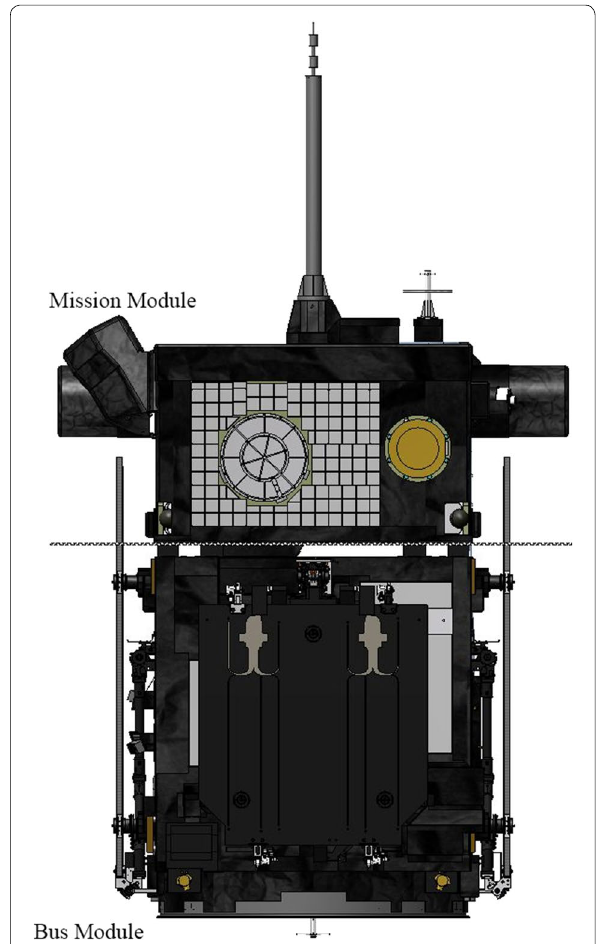
Fig. 1 Cross-view of the Arase spacecraft. The lower part of the broken line slightly above the middle is the bus module and the upper is the mission module. Observation equipment is attached to the mission module section and acquires observation data. The Arase satellite is a spin-stabilized satellite, and the spin axis is consistent with the S-ANT 3 attached to the top panel of the mission module. The bus module is oriented in the direction of the sun and the mis- sion module is designed to point in the opposite